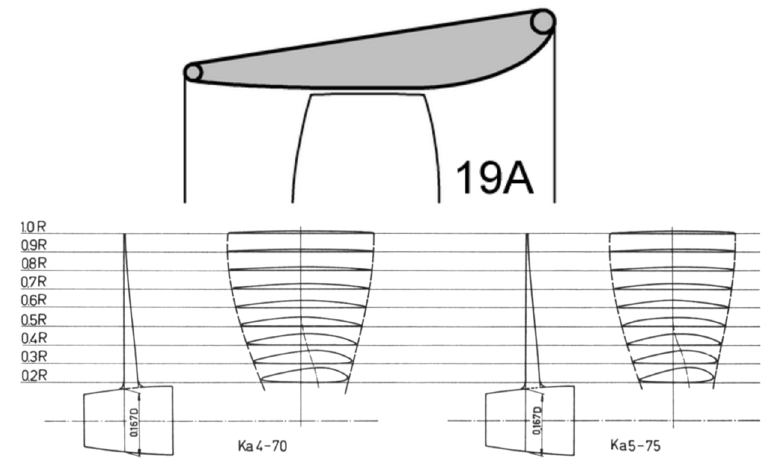
Figure 2. General plan of Wageningen B ‐ series [14].